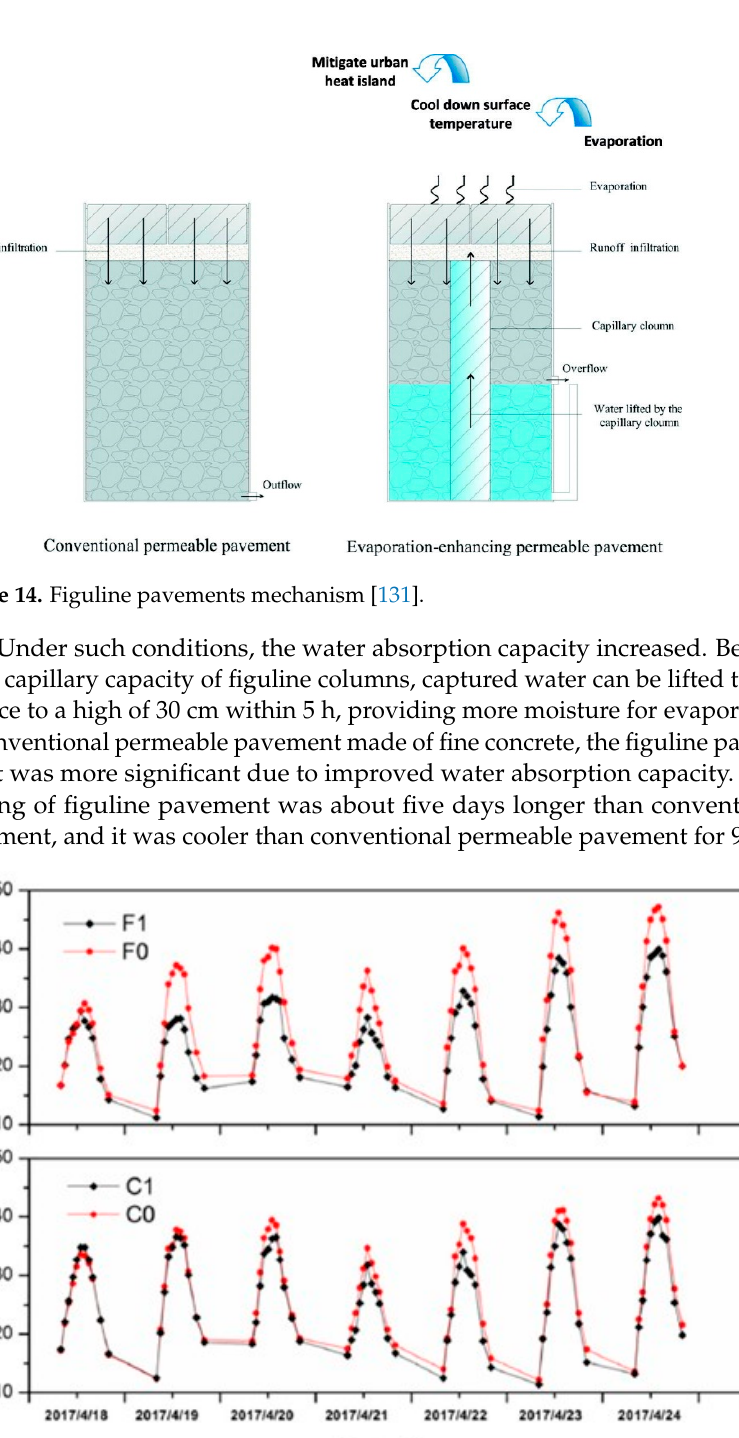
(C1) with capillary columns when compared with their controls (F0 and C0) without capillary